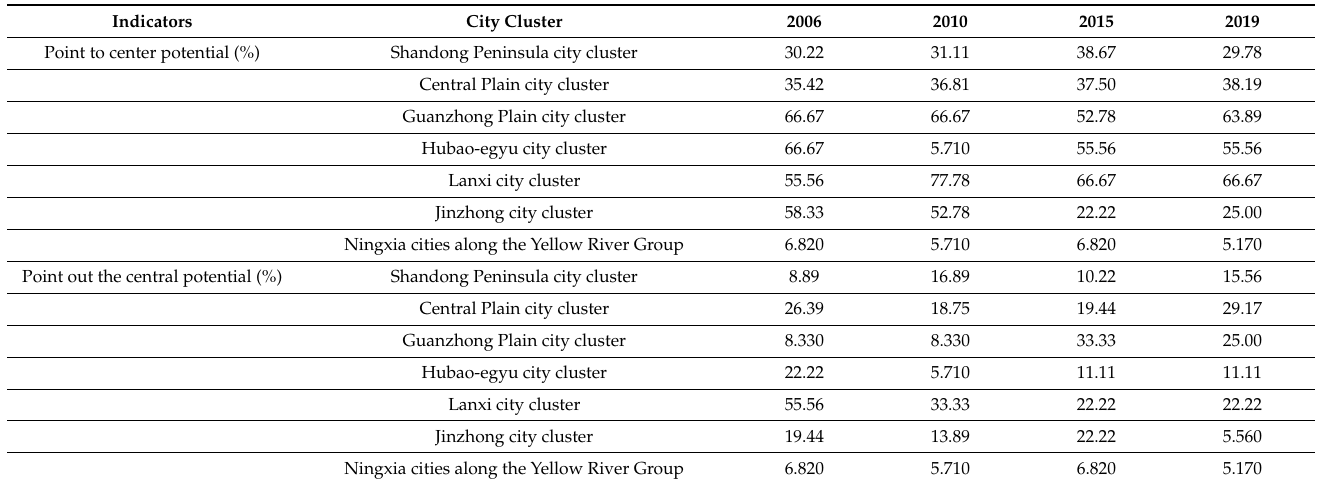
Table 2. Centrality of carbon efficiency in seven city